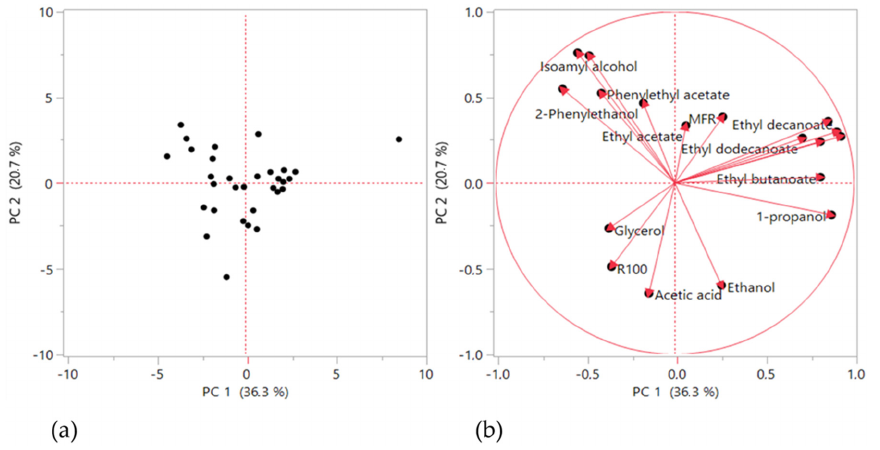
Figure 4. Principal Component Analysis (PCA) analysis of the 18 responses: ( a ) scores plot and ( b ) loadings plot for the first two principal components (PC1 explains 36.3% of the overall variability and PC2 explain